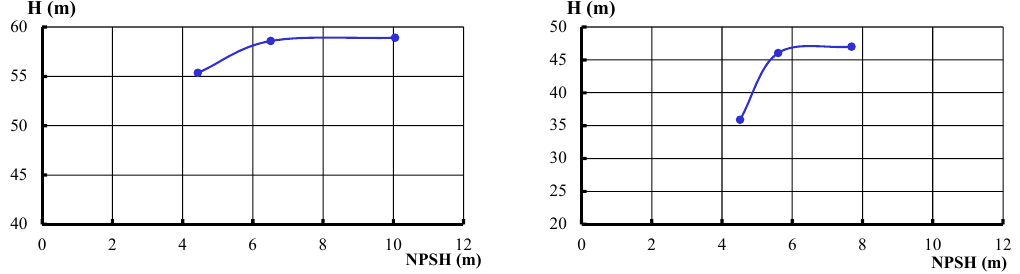
Figure 3. Two typical cavitation curves for the 30 kW pump.